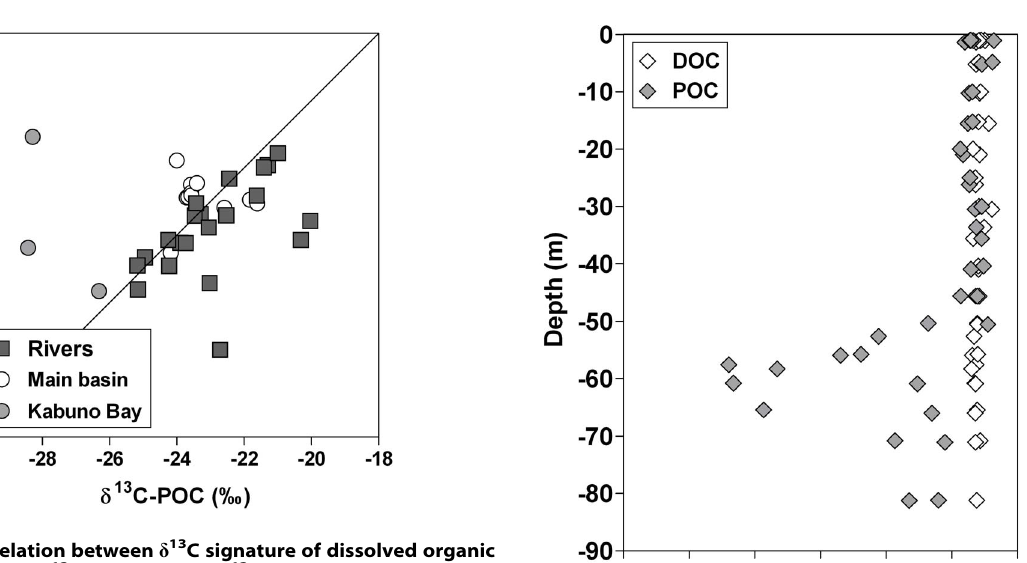
Figure 7. Relation between d 13 C signature of dissolved organic carbon (DOC) ( d 13 C-DOC, % ) and d 13 C signature of particulate organic carbon (POC) ( d 13 C-POC, % ), in the mixed layer of the main basin of Lake Kivu, Kabuno Bay and various inflowing rivers, in June 2008, April 2009, and October 2010. Solid line is the 1:1 line. Figure 8. Vertical profiles of d 13 C signature of dissolved